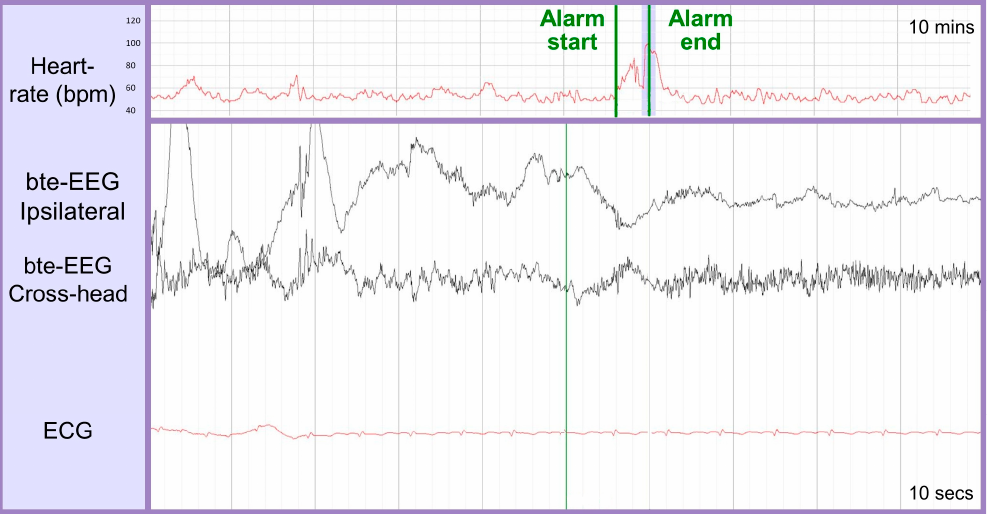
Figure 6. Example of a detected seizure segment mislabeled as a non-seizure on the bte-EEG experimental setup but corrected on the bte-EEG and ECG and heart rate setup (change from FN to TP). The top plot contains the heart rate data in red within a 10 min window, and the bottom contains the bte-EEG channels (in black) and ECG data (in red) within a 10 s window. The shaded section of the heart rate plot corresponds to the plotted area of the bottom one. The green vertical lines indicate the automated algorithm’s time events.